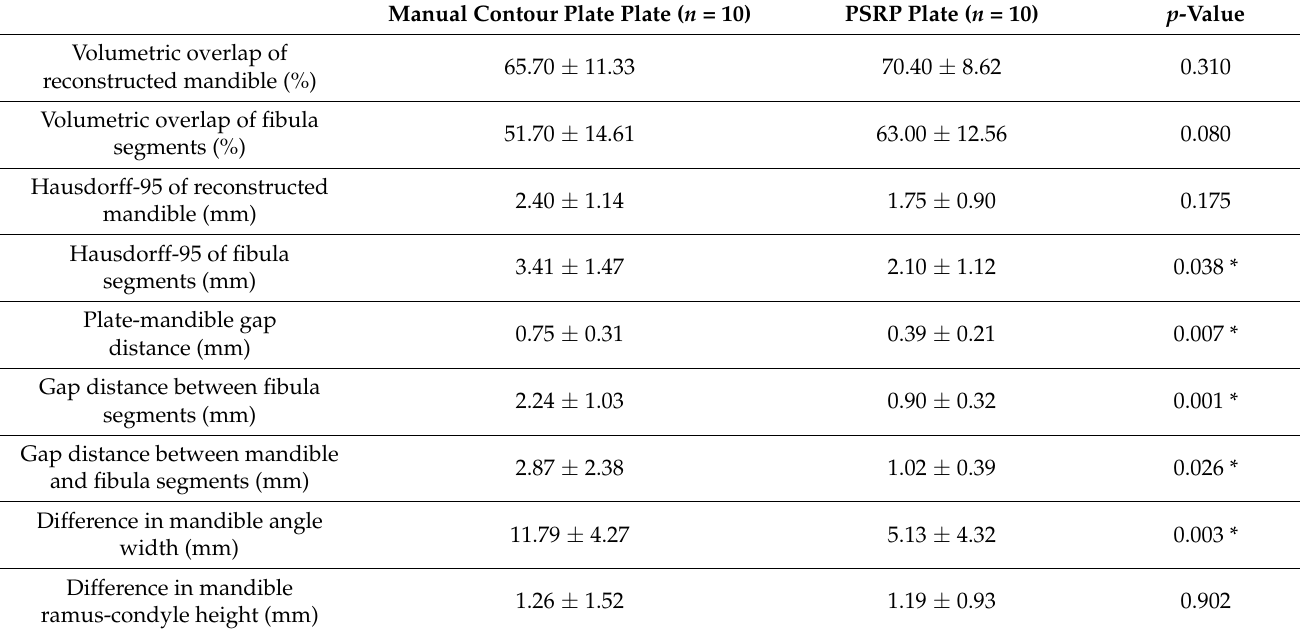
Table 2. Average accuracy measurements of the reconstructions in each group. Significant p -values are indicated with a